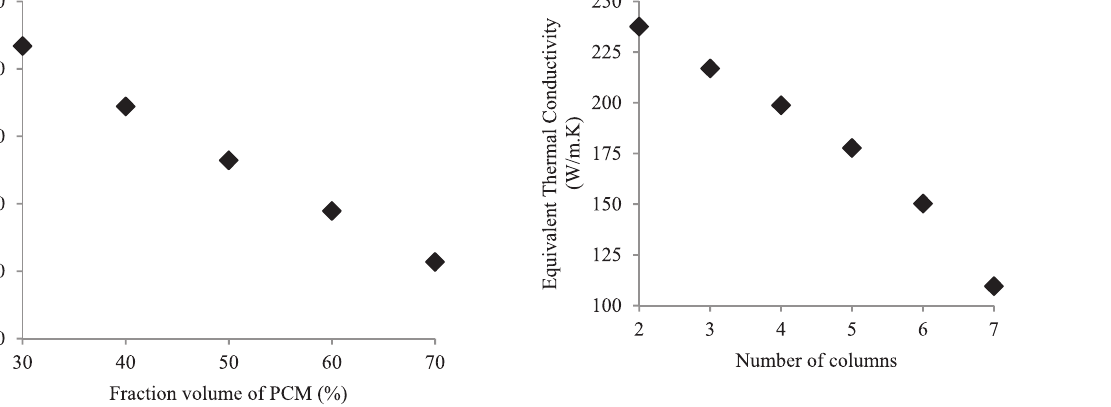
Fig. 5: Influence of the volume fraction of PCM, number of lines and columns constant